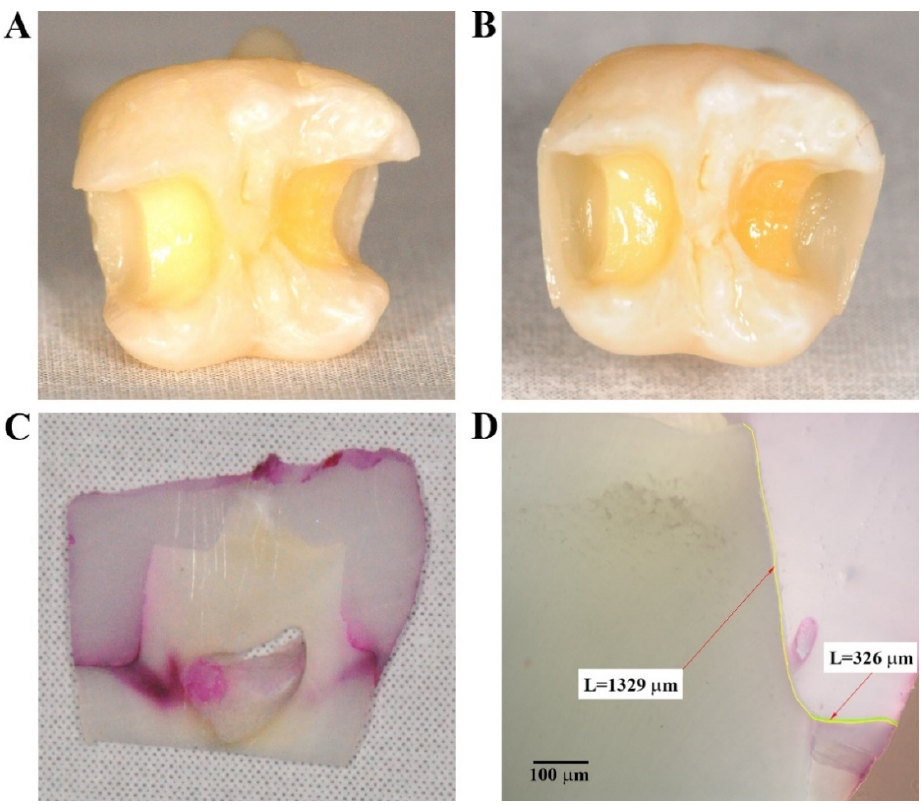
Figure 1. Phases in the preparation of the samples and microleakage evaluation. Class II cavities ( A ); prepared proximal walls ( B ); section containing two AF restorations—dye infiltration in cervical areas ( C ); optical microscopic image of a sample containing a cervical AF restoration—microleakage in dentin (40×) ( D ). Arrow = length ( μ m).